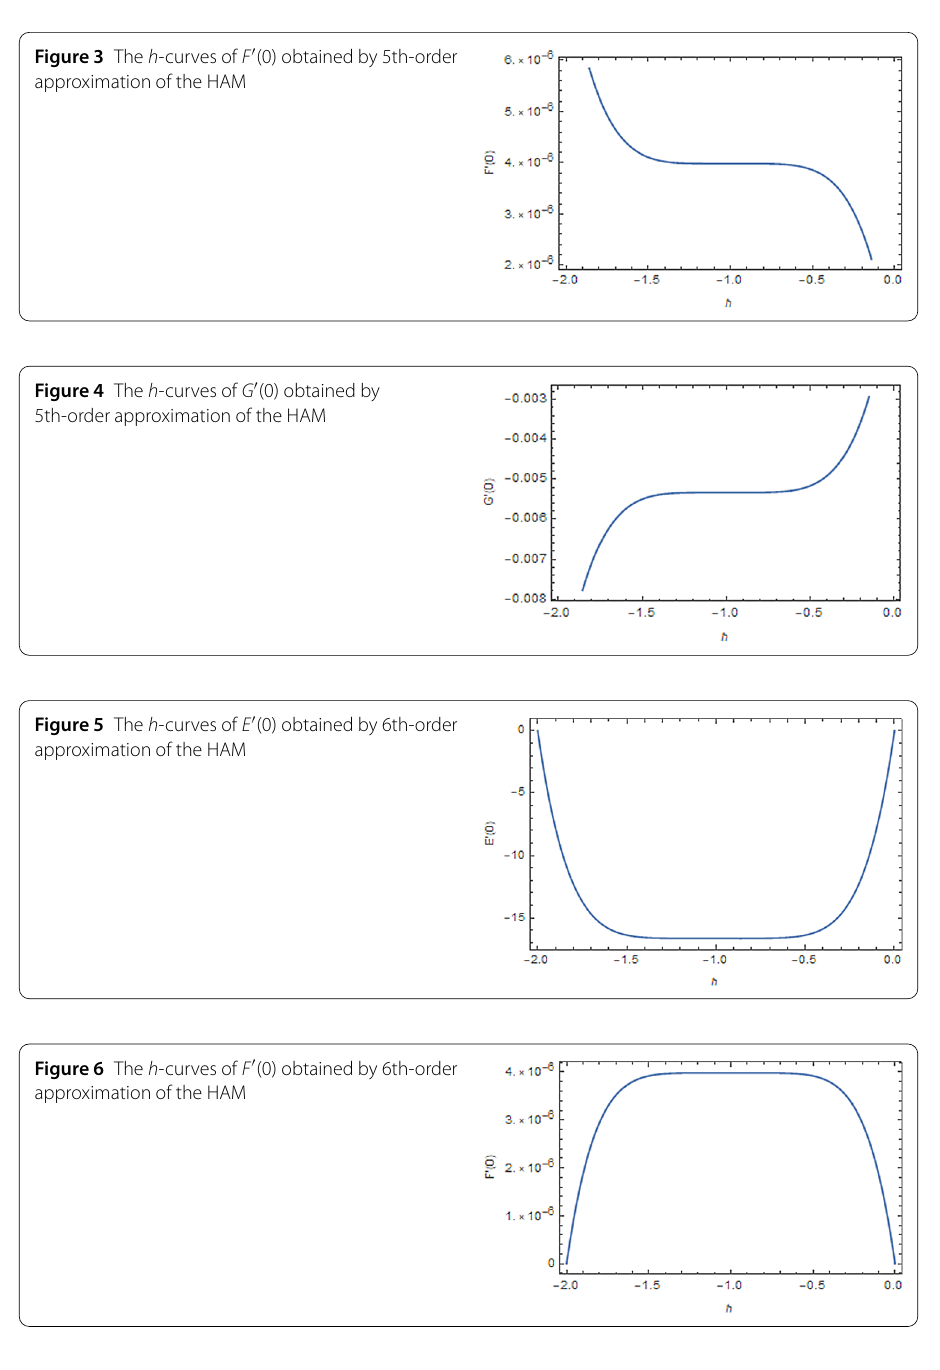
Figure 3 The h -curves of F (cid:10) (0) obtained by 5th-order approximation of the HAM